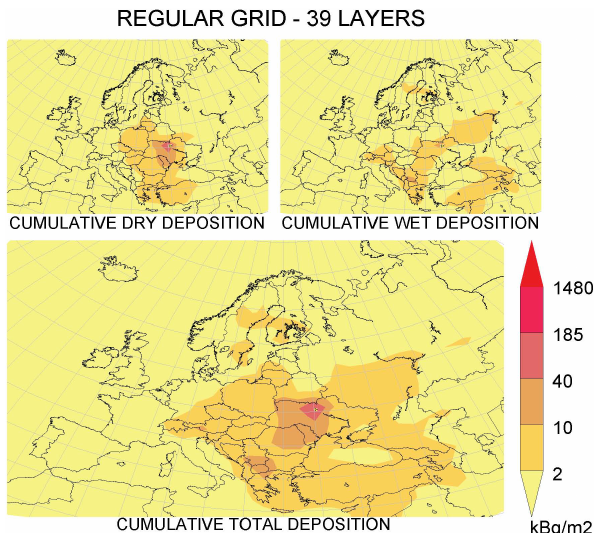
Fig. 14. Cumulative dry, wet and total deposition of 137 Cs (kBqm − 2 ) from the day of the accident (26 April 1986) until the end of 1986. Results of the simulation using the zoom-version of the model for 19 vertical layers and accounting for the altitude of the emissions with respect to Table